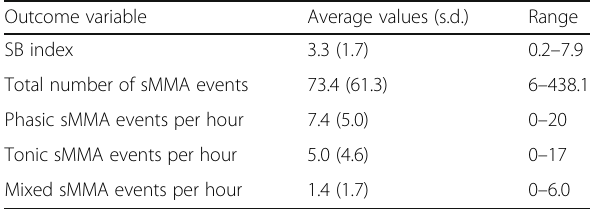
Table 2 Average values (standard deviation (s.d.)) of outcome variables during the four recording nights Outcome variable Average values (s.d.) Range